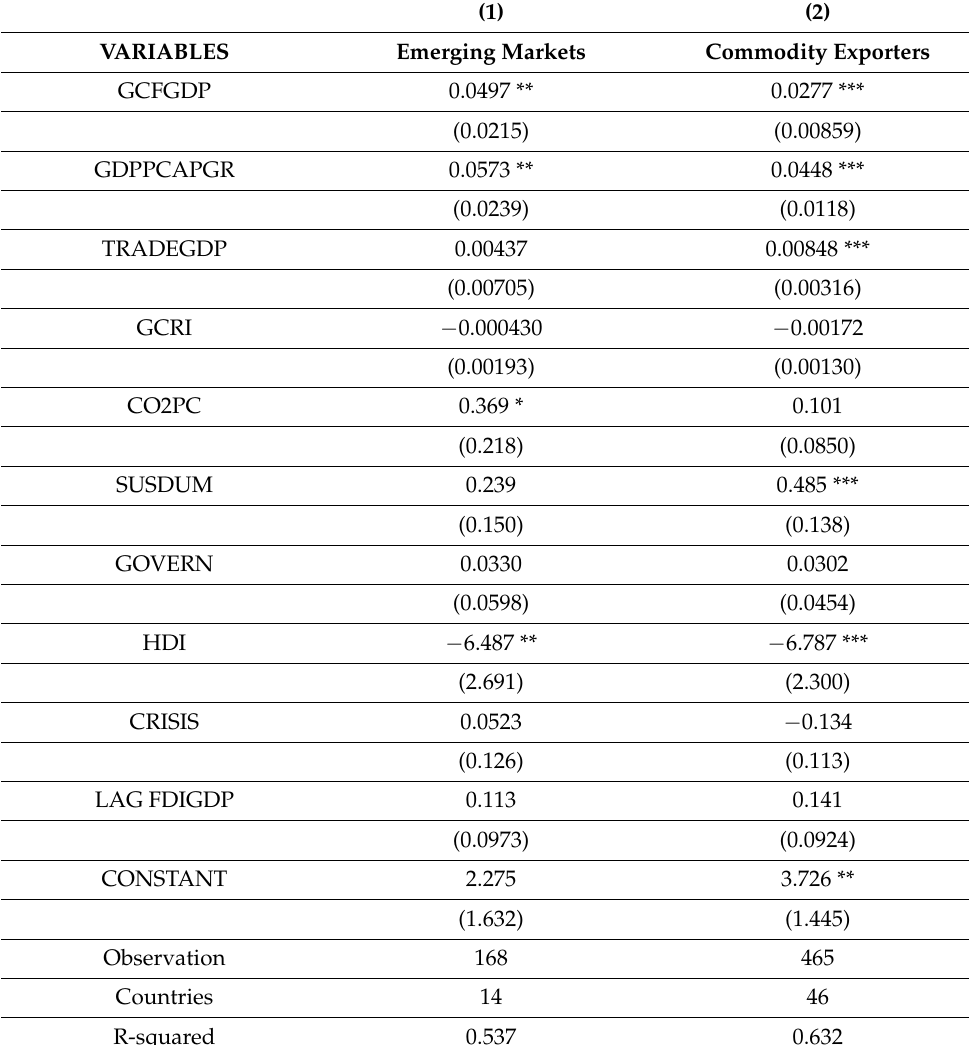
Table 4. FDI Inflows as a percentage of GDP: results for low- to middle-income emerging market countries and commodity